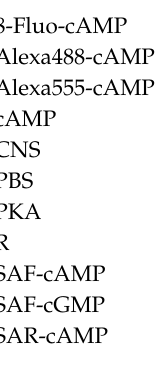
Table S1: Patients; Figure S1: optimization of fixation protocols; Figure S2: fluorescent cAMP binding to meningioma, case 3; Figure S3: fluorescent cAMP binding to meningioma, case 5; Figure S4: Original single-channel images, relative to Figure 3; Figure S5: western